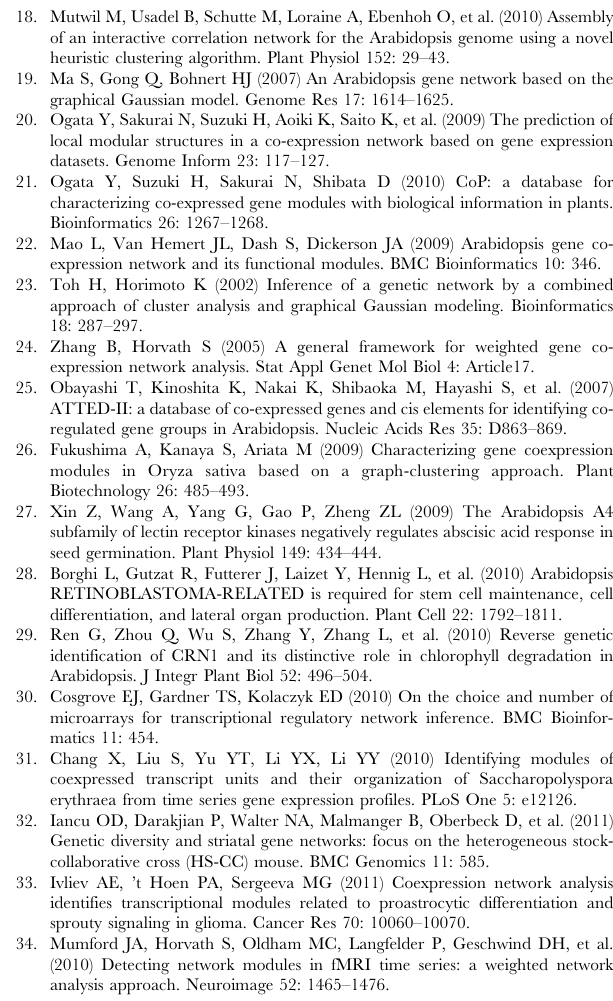
Table S1 Descriptions of CEL files used for coexpres- sion analyses. Table S2 Description of numbers of arrays used for each sample from each expression data set analyzed for coexpression analysis. Table S3 List of module names, member genes and gene functional annotations from condition-dependent network analyses. Table S4 Pfam domain enrichment within condition- dependent gene coexpression modules. Table S5 Membership of genes in three coexpression modules enriched in Pfam domains for cytochrome P450, chitinase and terpene synthases.